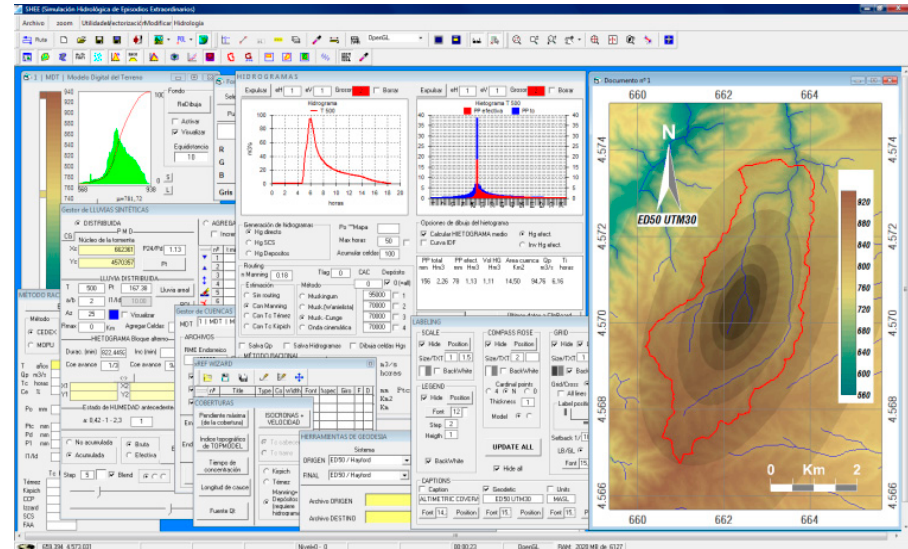
Figure 1. The Simulation of Hydrological Extreme Events (SHEE) program interface. This program uses digital terrain models and hydrological models, and actual or simulated rain, soil moisture, and circulation through the drainage network.